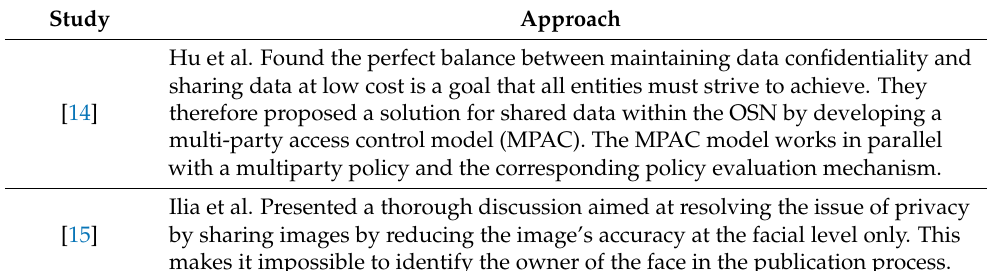
Table 1. Summarizing related